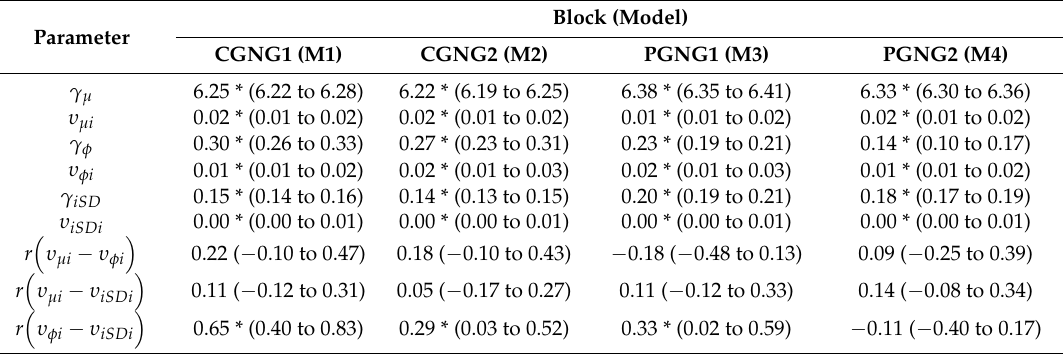
Table 2. Posterior means (and 95% credible intervals) of fixed effects, random effect variances, and correlations between random effects estimated from models M1 to M4. Mean fixed effects and random variances are shown in raw metrics; correlations and regression weights are shown in within-level standardized